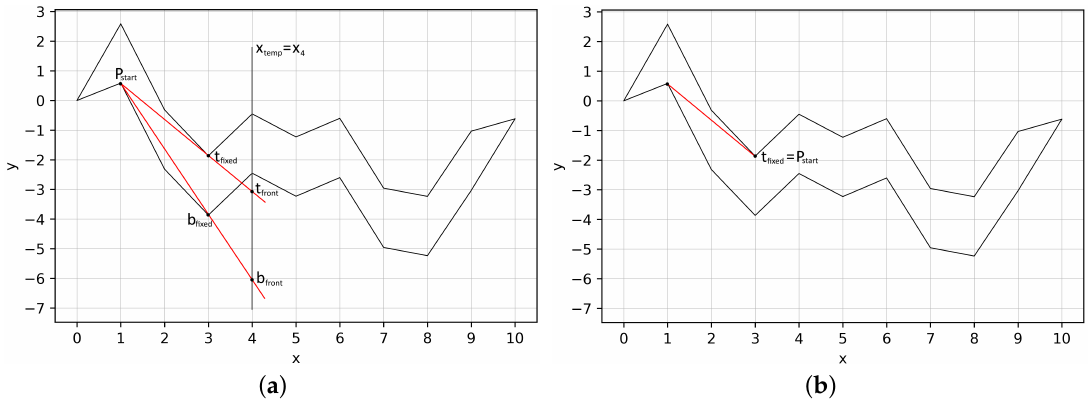
Figure 8. ( a ) Scanning cone with temp = 4; ( b ) fixed part of the taut